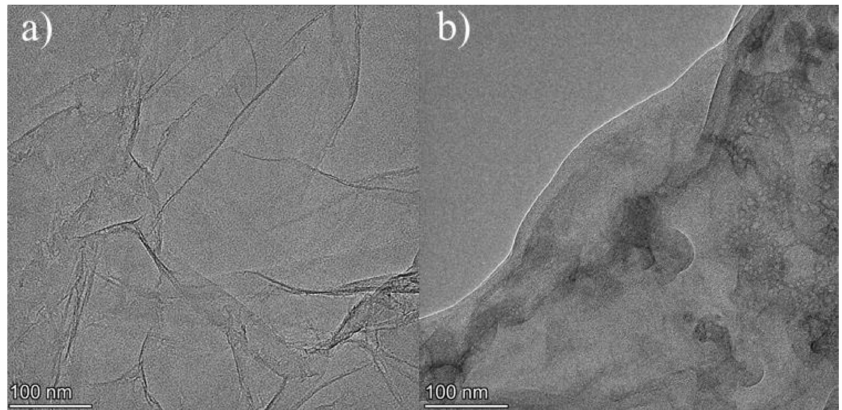
Figure 4. TEM images: ( a ) GO and ( b ) rGO.